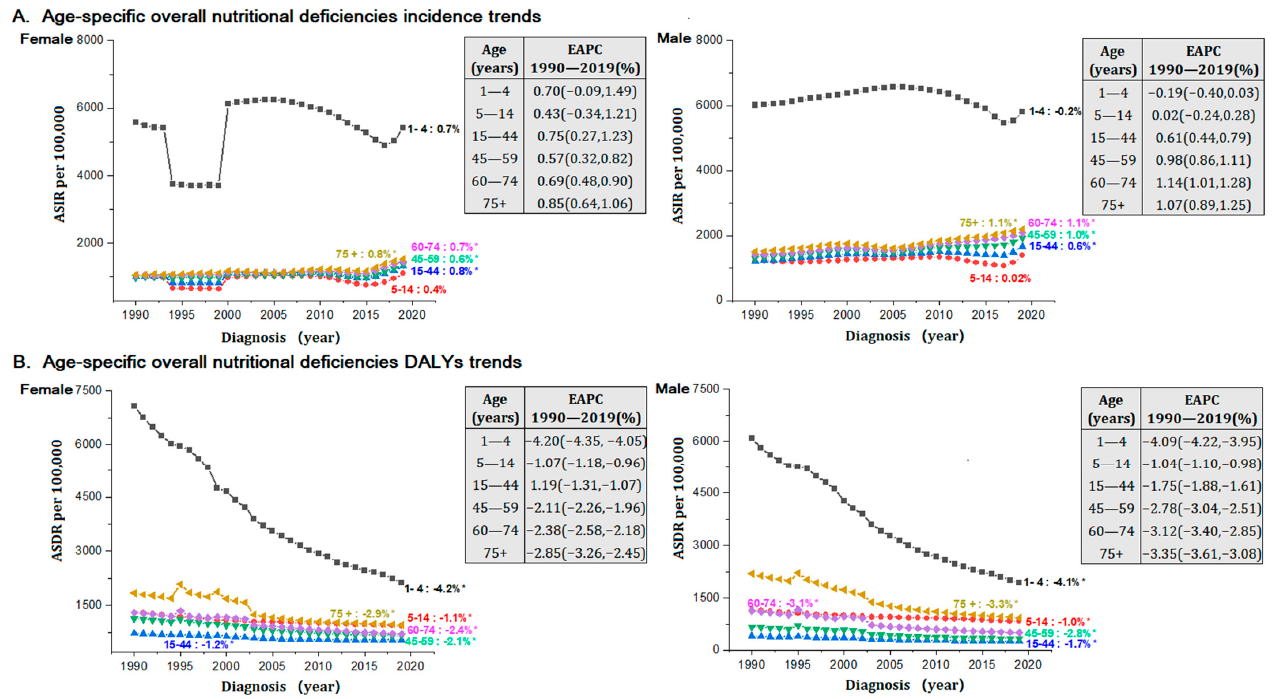
Figure 3. The age-sex specific trends of age-standardized incidence rate and age-standardized DALYs rate for nutritional deficiencies (NDs) in LMICs from 1990 to 2019. ( A ) Age-standardized incidence rate (ASIR); ( B ) age-standardized DALYs rate (ASDR). DALYs, disability-adjusted life years; EAPC, estimated annual percent change. Note: (*) Indicates statistically significant trend (p < 0.05).